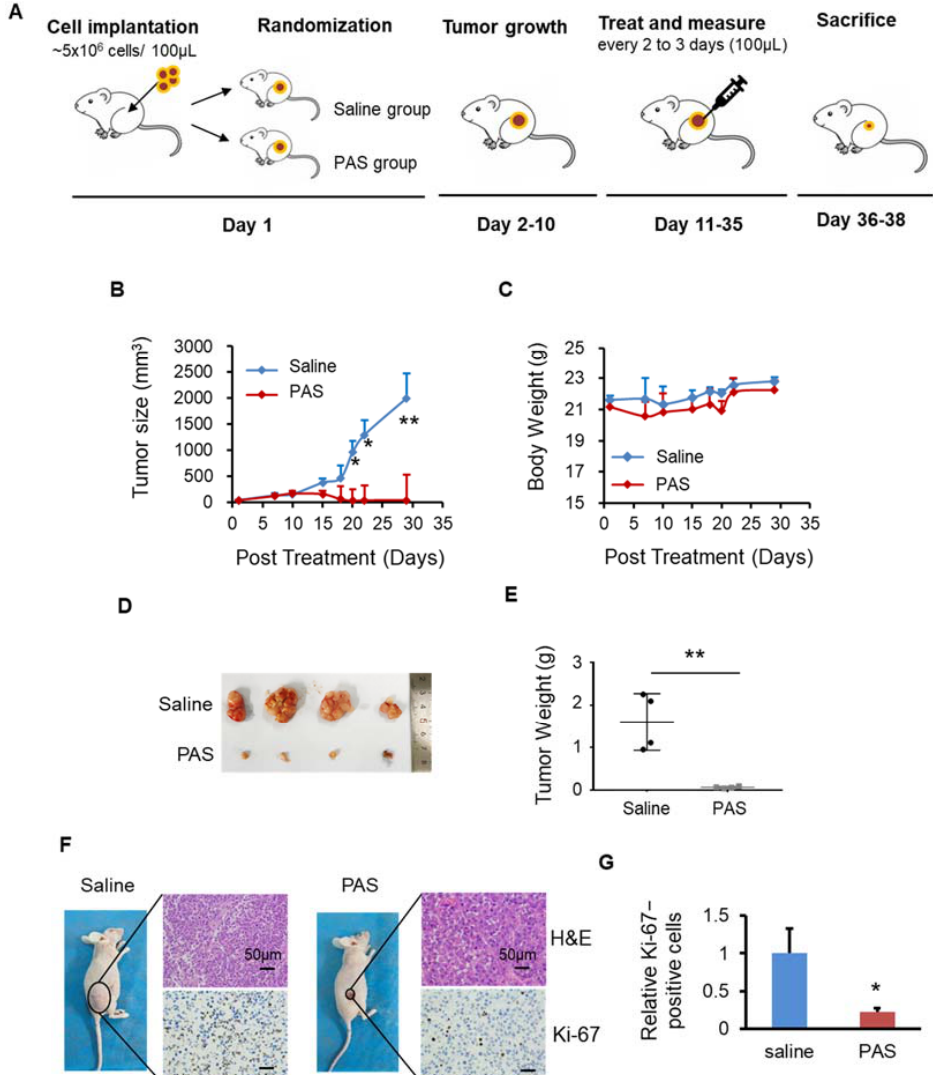
Figure 2. Plasma-activated saline (PAS) injection significantly suppressed A375 xenograft tumor growth in vivo. ( A ) Illustration of the three tumor models. Nude mice bearing A375 xenografts were grouped and treated with saline or PAS. The tumor size ( B ) and body weight ( C ) were measured. After the experiment was terminated, tumors were harvested ( D ) and weighed ( E ). Tumor sections were stained with hematoxylin and eosin (H&E) (upper panel), Ki-67 (lower panel) ( F ). ( G ) Quantitative analyses of Ki67-positive cells were performed with ImageJ. Data represent the mean ± SD; n = 4; * p < 0.05; ** p < 0.01; scale bar = 50 µ